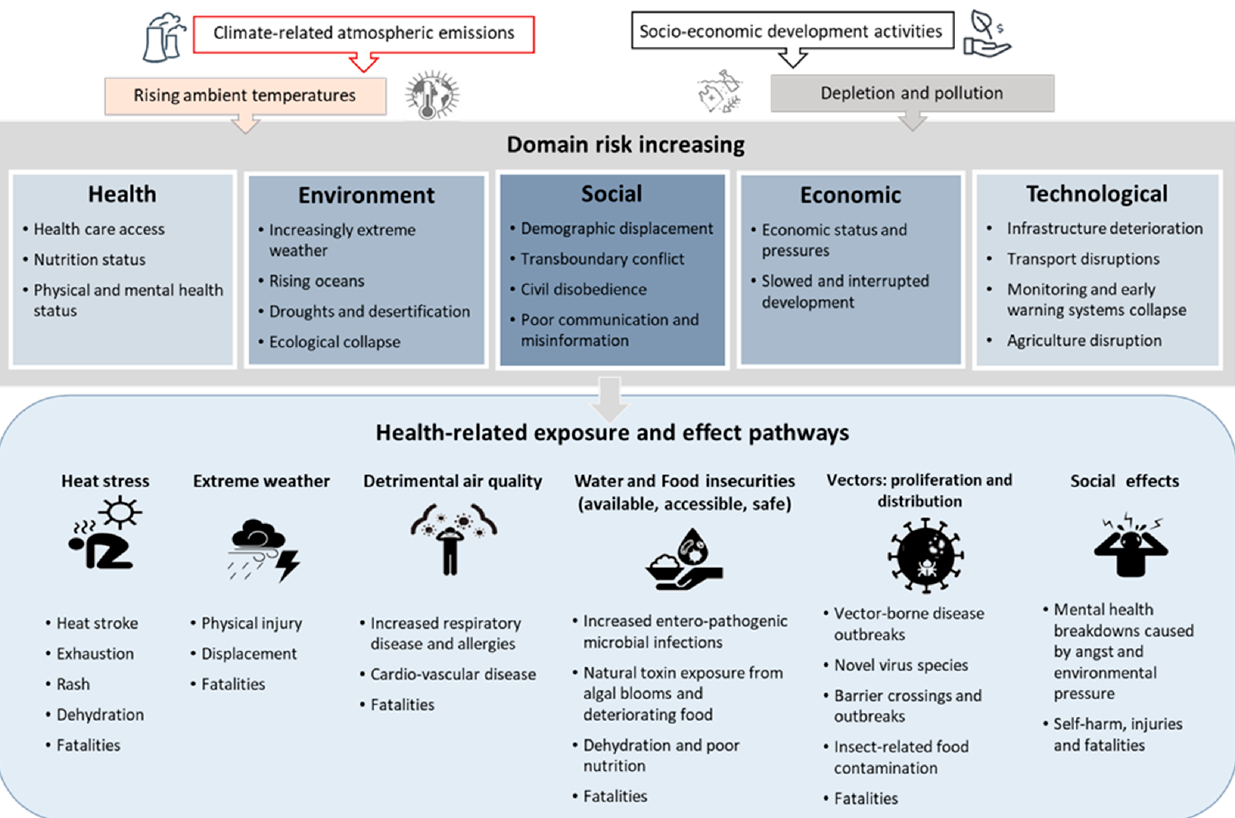
Figure 1. Examples of major health risks associated with climate and environmental change. This Figure 1 is developed from insights from [3,5,17] and is not intended to be comprehensive. Table 1. Core Climate and Environmental Change for Health Competencies for education and training of Health Workers.